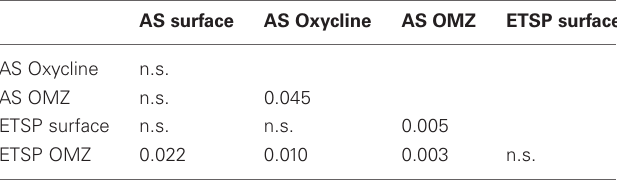
Table 2 | Summary of p values of Multi-Response Permutation Procedure comparing different AOA communities